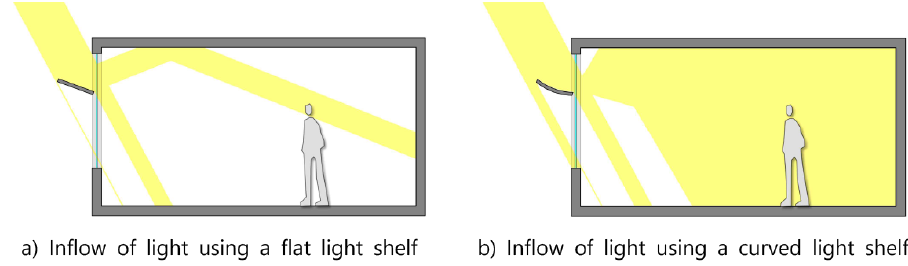
Figure 4. The inflow of light achieved using flat and curved light shelves.